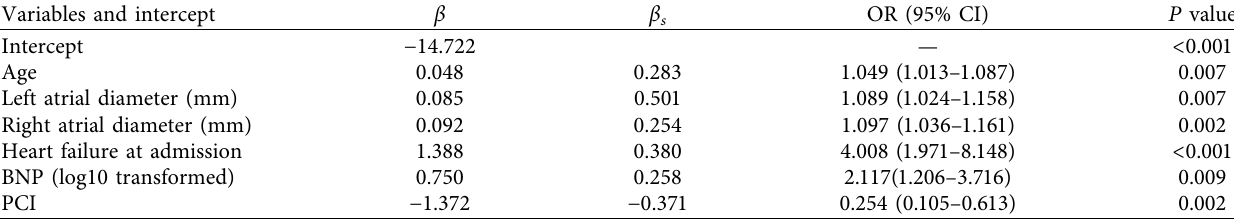
Table 3: Multivariable logistic regression analysis of NOAF in UA